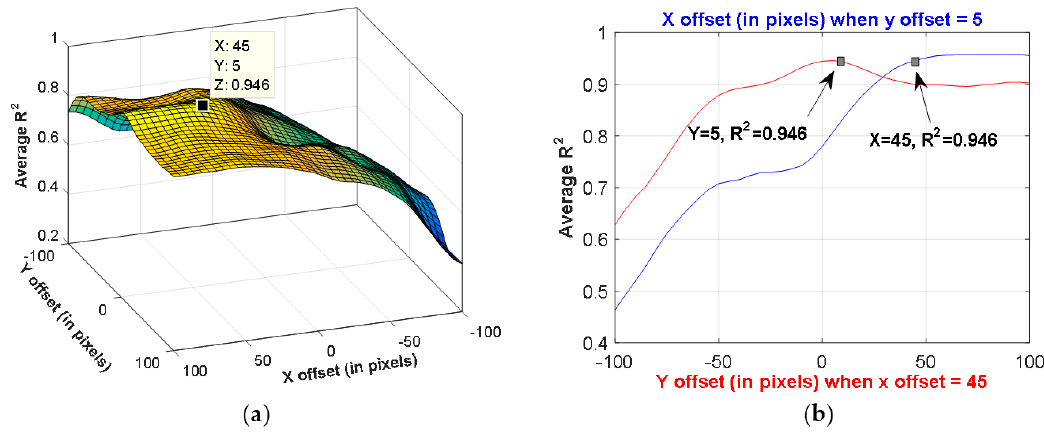
Figure 6. Site 1 data alignment. ( a ) The distribution of R 2 between the multispectral camera image brightness and spectrometer reflectance for spatial domain offsets ( ∆ x , ∆ y ) up to ± 100 pixels at time offset dt = − 0.2 s. ( b ) the separate X (left) and Y (right) profiles through the optimal